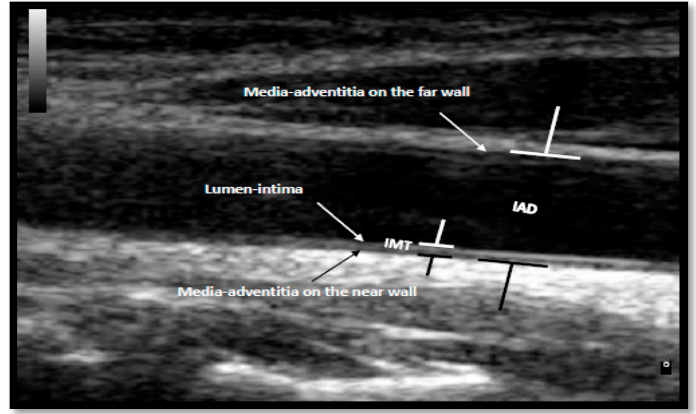
Figure 1. Illustration of intima-media thickness (IMT) and inter-adventitial diameter (IAD) measurements on a participant’s common carotid artery (CCA) ultrasound image.